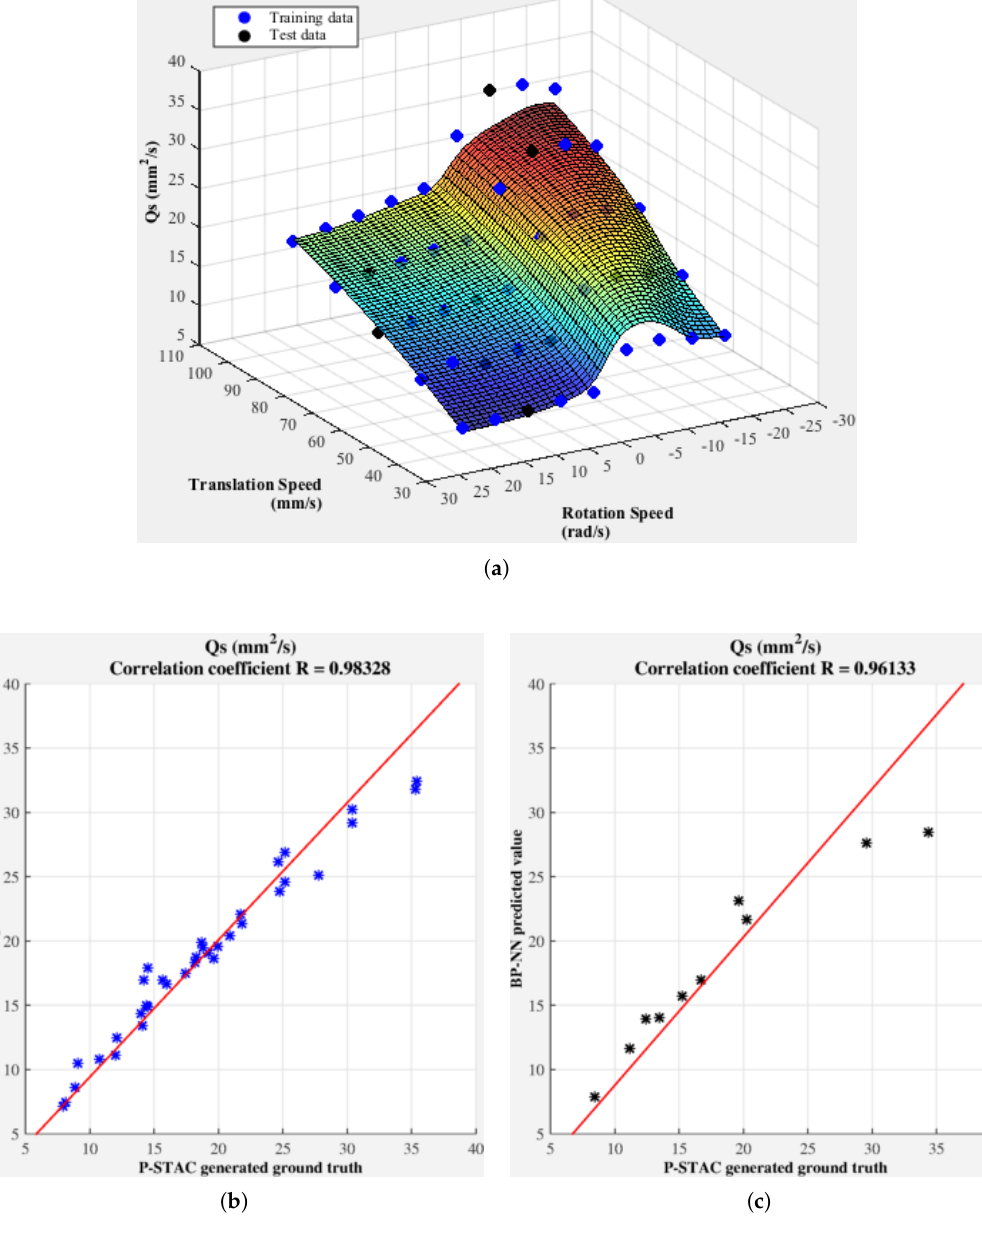
Figure 7. BP-NN predictions for the spreadability metric of spread throughput, Q s for the case of spreading Ti-6Al-4V powder on an additively manufactured spreading substrate with S q = 79 µ m ( a ) Regressed surface ( b ) Training data ( c ) Test